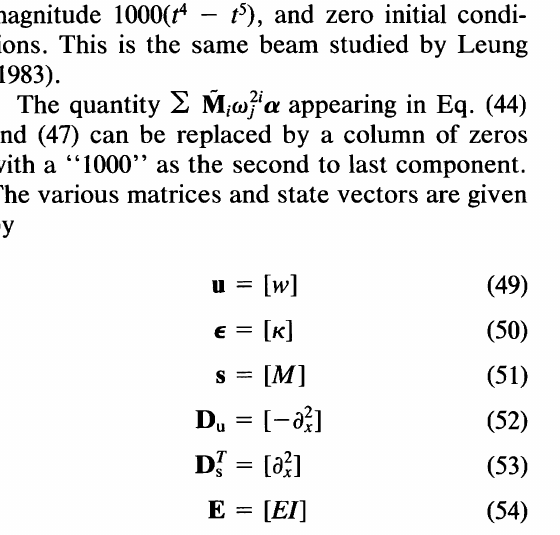
FIGURE 1 Percent error in the calculated deflection of the free end at time t = 1.0 s using available